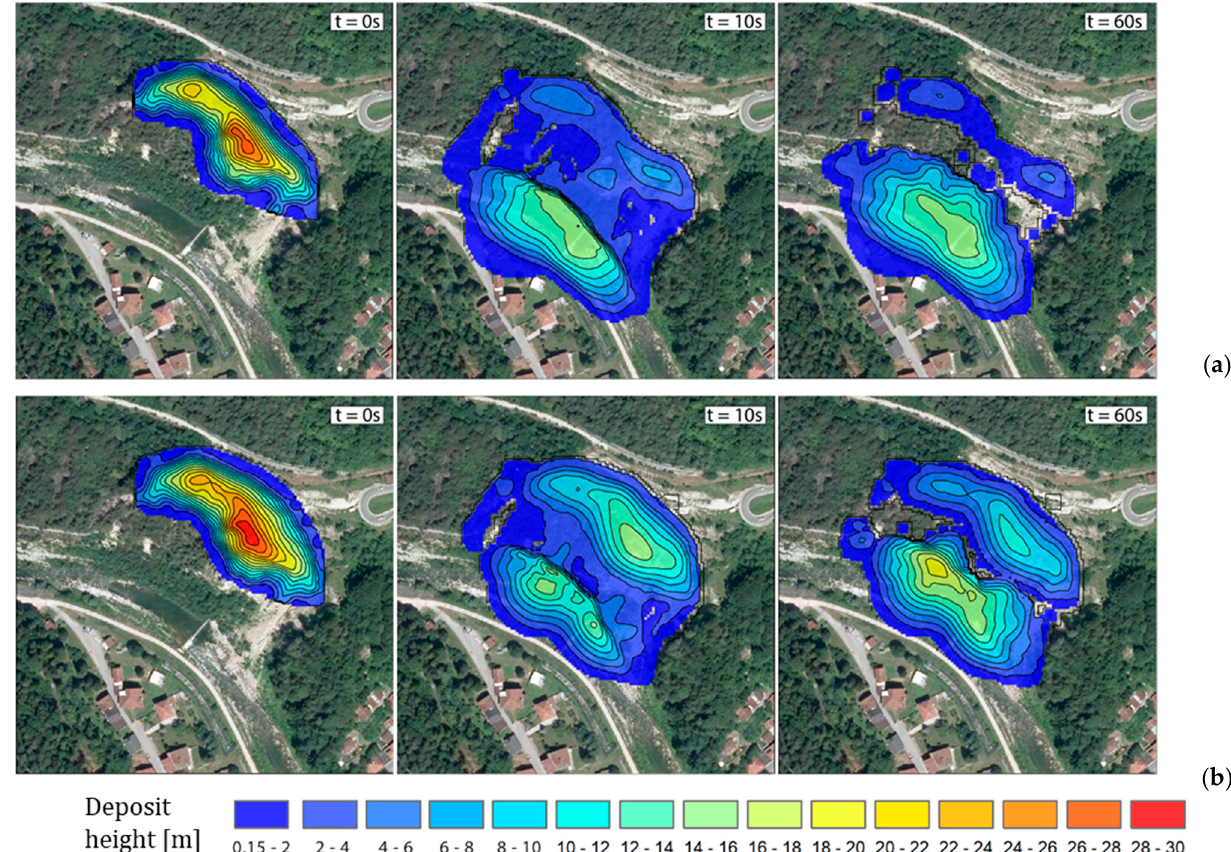
Figure 12. Some simulated steps (t = 0 s; t = 10 s; t = 60 s) of the landslide propagation in ( a ) wet and ( b ) dry conditions